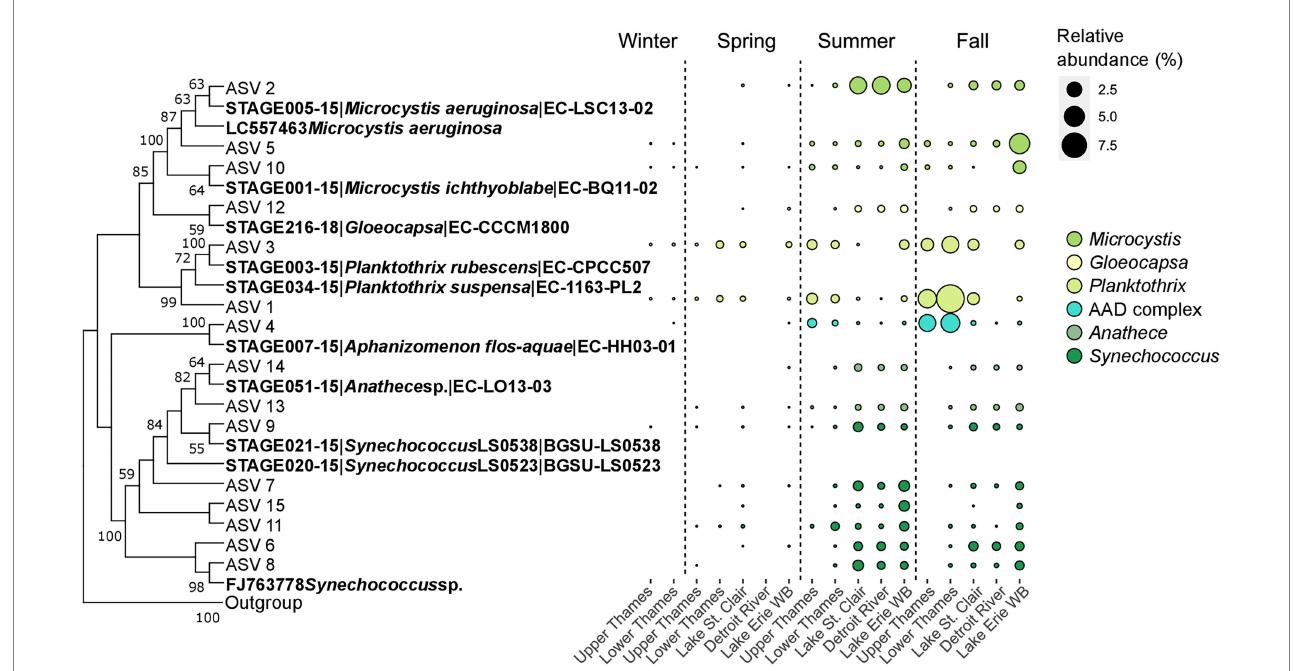
FIGURE 6 Neighbor-joining bootstrapped phylogenetic tree of the 15 most abundant cyanobacterial ASVs with sequences from culture representative of the BOLD reference database and sequences downloaded from GenBank with only bootstrap values above 50% from the 1,000 replicated trees indicated at the nodes of branches (A) . Corresponding relative abundance in % of the microbial community of the single ASVs along the water continuum and across season colored based on their genera (B) . WB stands for Western